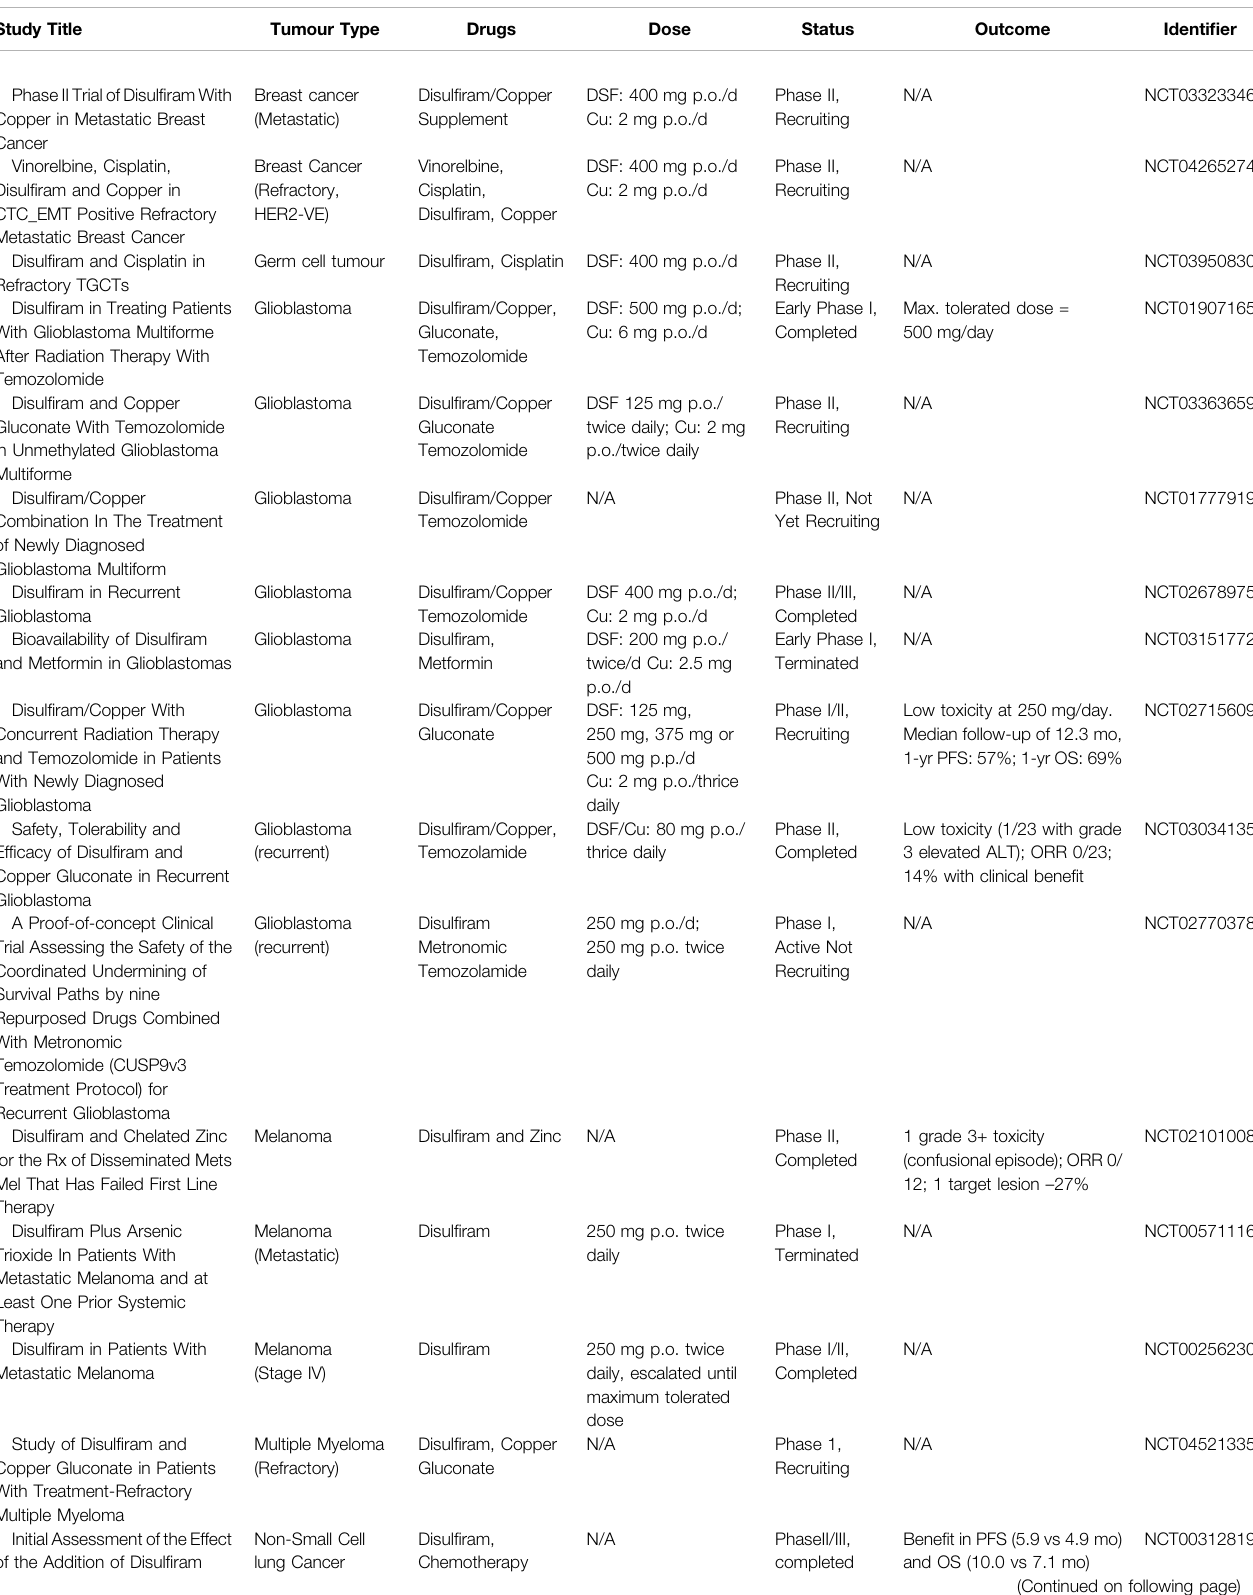
TABLE 2 | Summary of clinical trials using disul fi ram for cancer